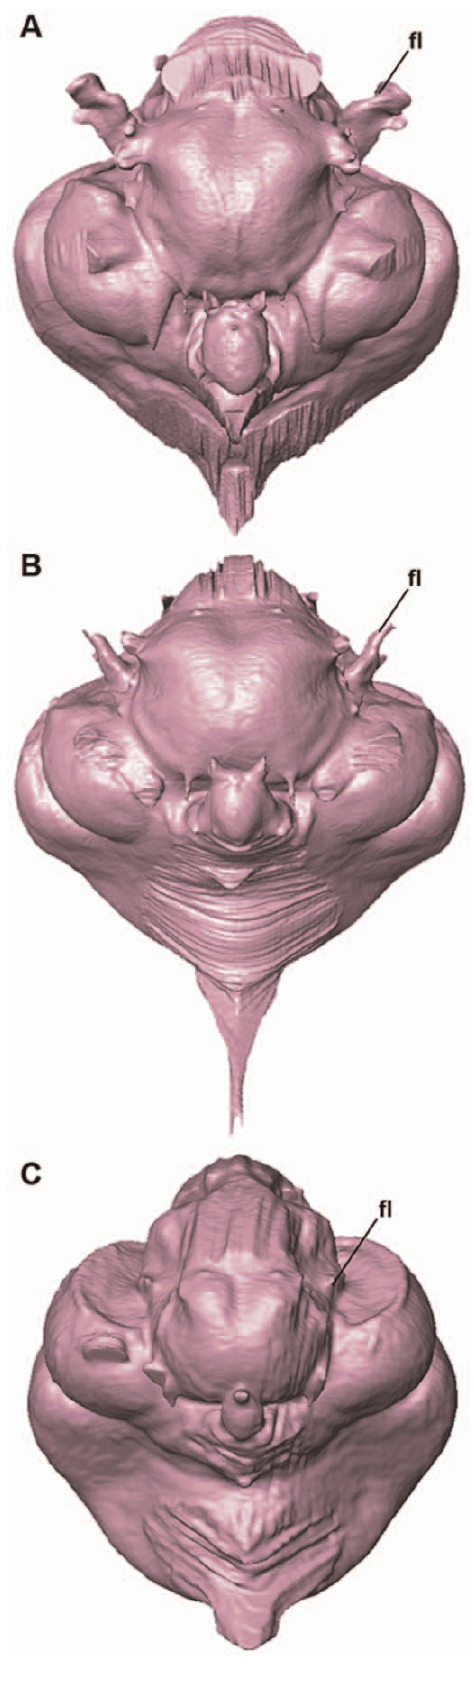
Figure 13. Ventral views of endocranial endocasts of the Pigeon Guillemot Cepphuscolumba (A), Crested Auklet Aethia cristatella (B), and Black-legged Kittiwake Rissa tridactyla (C) showing differences in the relative size and morphology of the floccular